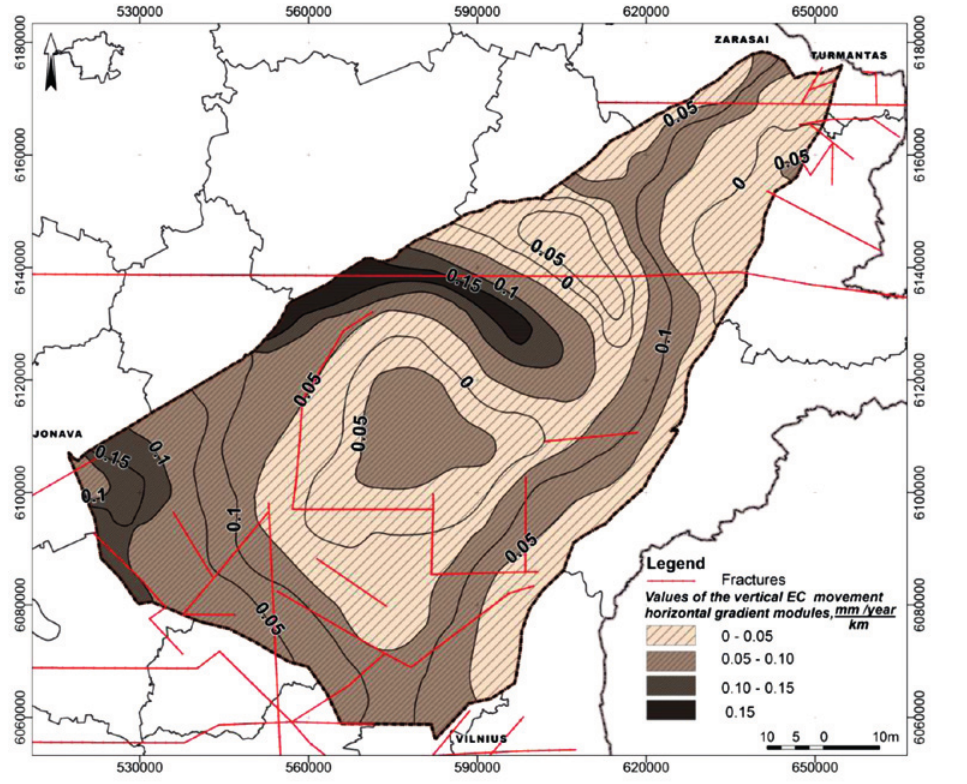
Fig. 6. Modules of horizontal gradients of recent vertical earth’s crust movement velocities in Vilnius–Jonava–Zarasai–Turmantas–Vilnius levelling